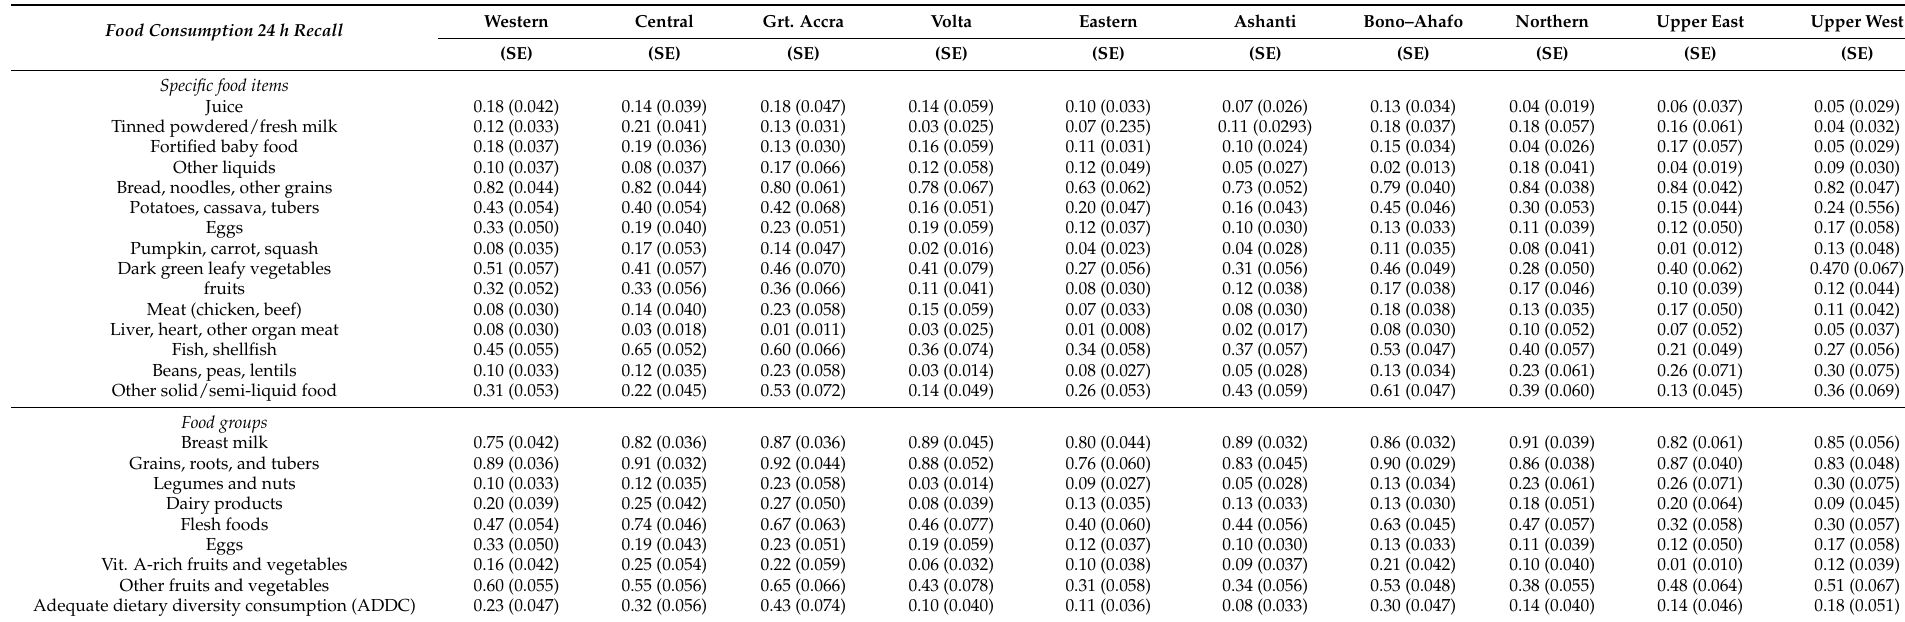
Table 8. Average Predictive Margins (APMs) with standard error (SE) for a geographical area on consuming specific food items and food groups among children aged 6–23 months,